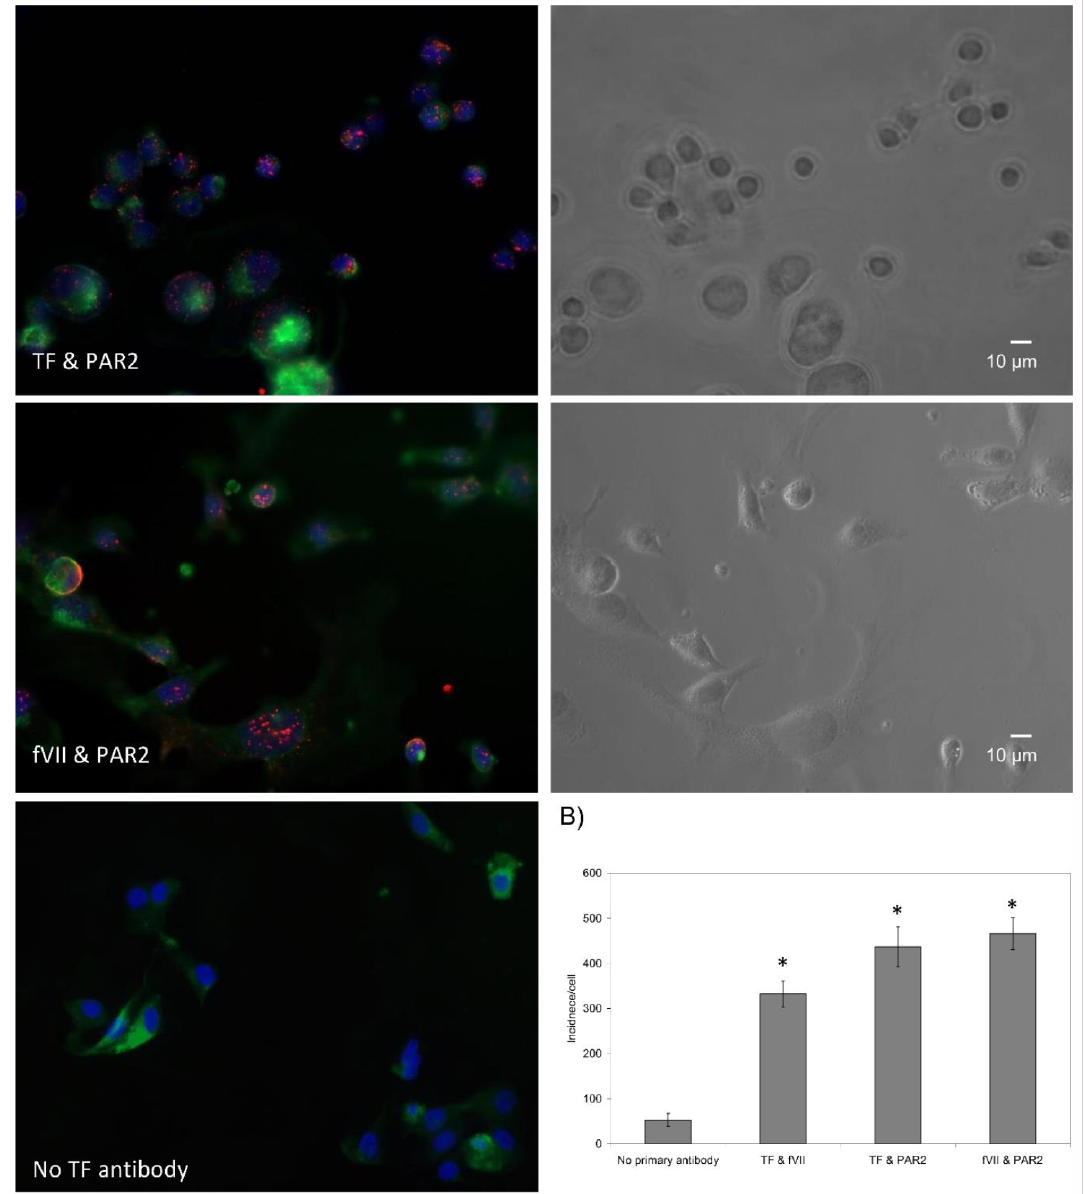
Figure 1. Analysis of the association between TF, fVII and PAR2 on the surface of cells: MDA-MB-231 cells (10 3 ) were seeded out into 35 mm-glass based µ -dishes and incubated overnight. Cells were then fixed with 4% ( v / v ) paraformaldehyde for 15 min, washed three times with PBS for 5 min and blocked with Duolink blocking buffer for 1 h. The cells were then incubated overnight at 4 ◦ C with combinations of antibodies as follows: the cells were probed with a mouse anti-fVII antibody (321621; 10 µ g/mL) together with a rabbit anti-TF antibody (FL295; 5 µ g/mL) to examine the interaction between fVII and TF. Another set of cells were probed with a rabbit anti-TF antibody (FL295; 5 µ g/mL) and a mouse anti-PAR2 antibody (SAM11; 20 µ g/mL) to examine the association of TF and PAR2 proteins. Finally, to test the proximity between fVII and PAR2, the cells were probed with a polyclonal rabbit anti-fVII antibody (10 µ g/mL) together with mouse anti-PAR2 antibody (SAM11). ( A ) The dishes were washed three times with PBS and PLA performed according to the manufacturer’s instructions. The cells were stained with DAPI (2 µ g/mL) and Phalloidin-FITC (2 µ g/mL). Images were acquired using a Zeiss Axio Vert.A1 inverted fluorescence microscope with a 40 magnification. A different representative of the control × samples in which one primary antibody was substituted with a isotype control is presented in each of the figures. ( B ) The number of red fluorescent events and nuclei were determined as incidence/cell in 10 fields of view from each assay using the ImageJ program. ( n = 4; * = p < 0.05 vs. the